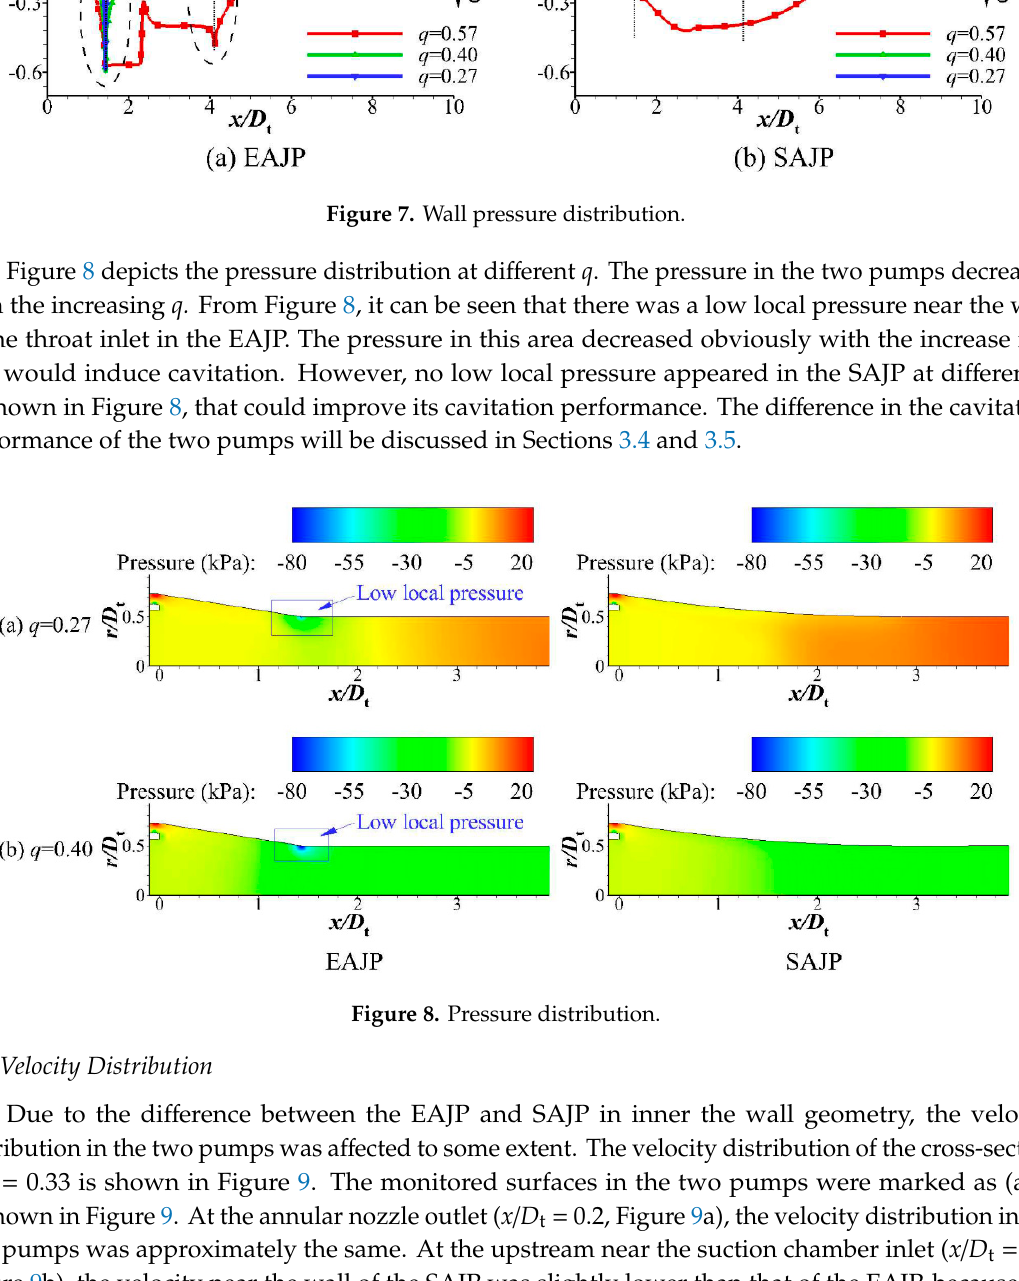
Figure 7. Wall pressure distribution.